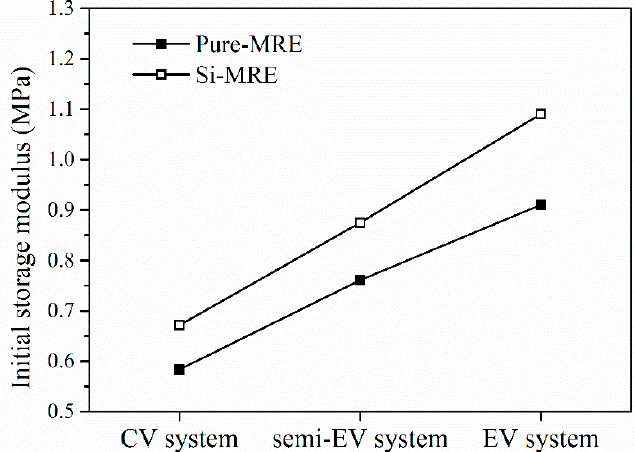
Figure 4. Zero-field modulus of the MRE and Si-MRE with various vulcanization systems.